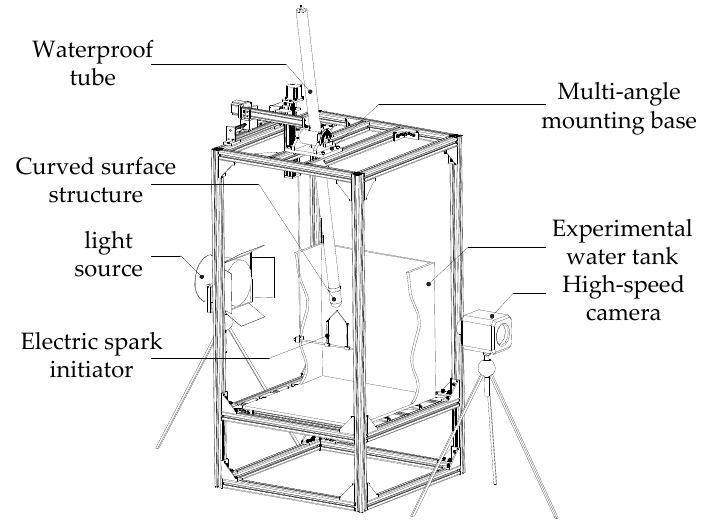
Figure 4. Experimental setup.